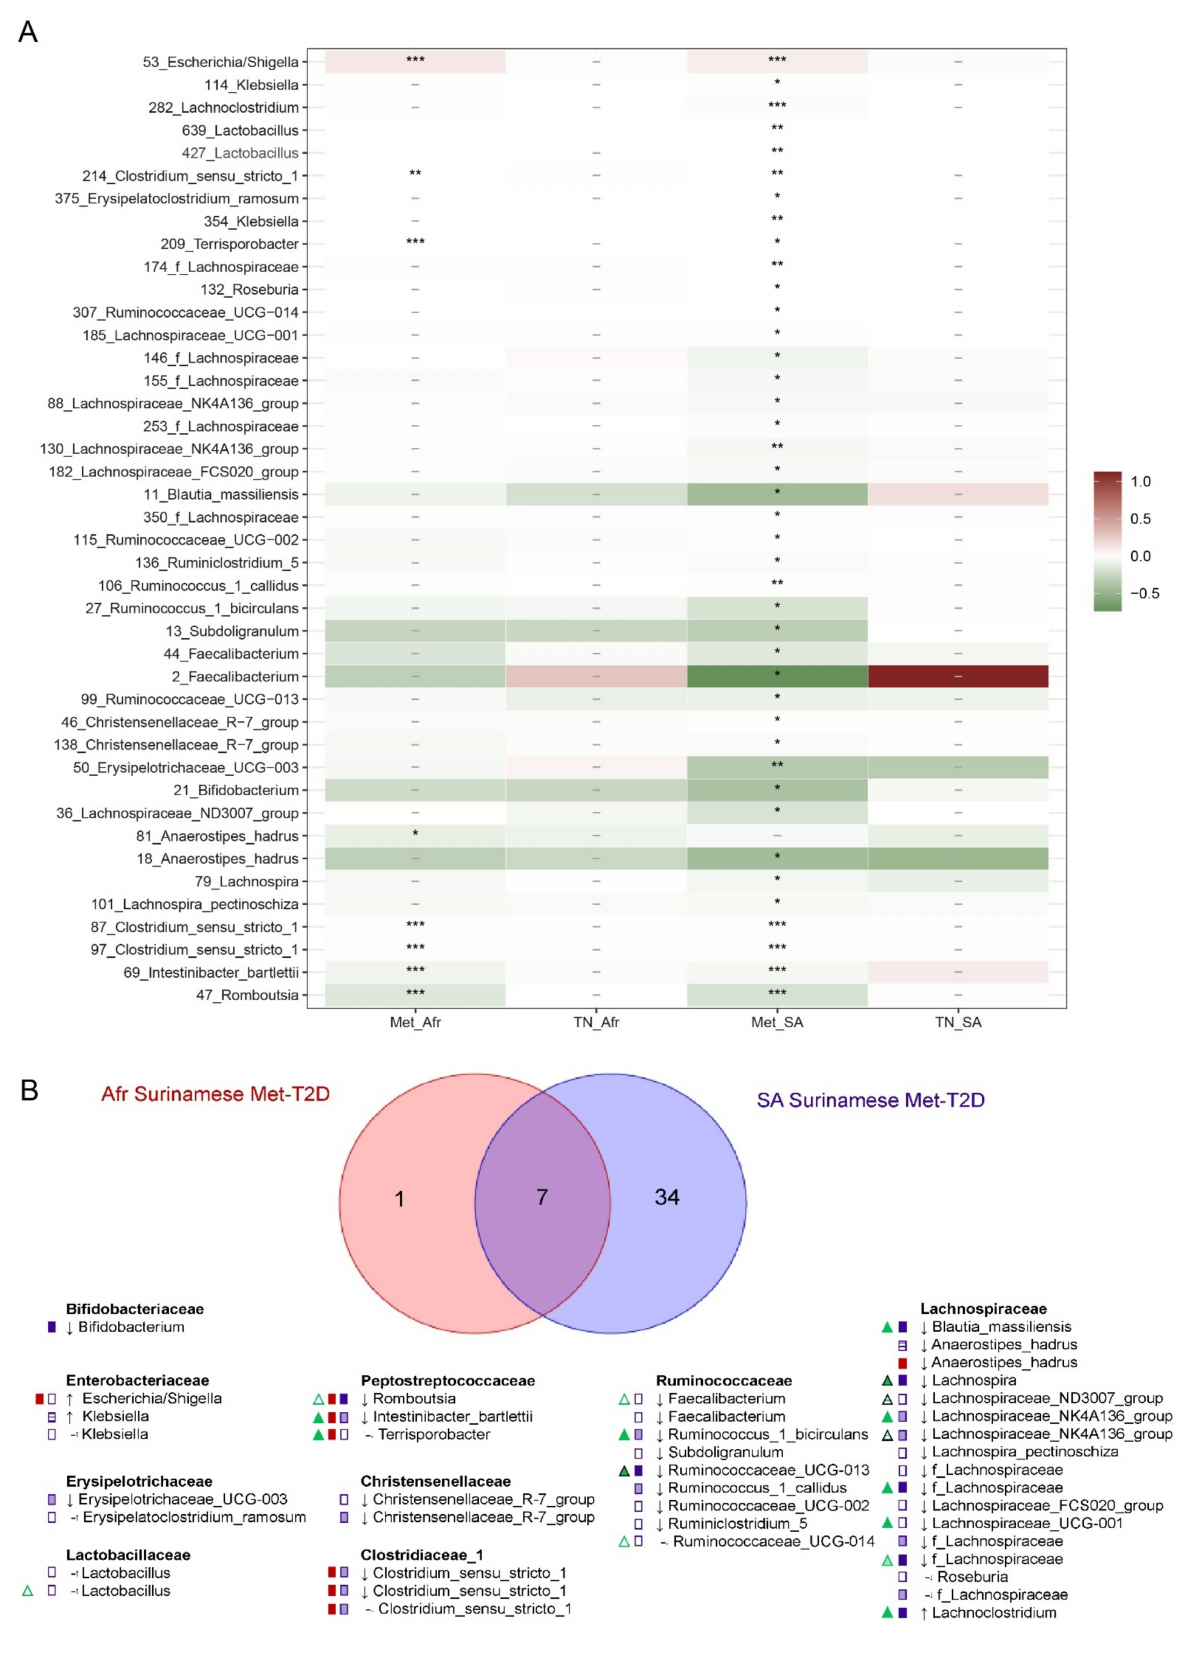
Figure 3. Overview of the Wilcoxon analysis and sensitivity analysis on ASVs for all datasets (T2D cases and their matched controls). ( A ) Overview of the Wilcoxon analysis on the ASVs for all datasets. Only features that were significant in at